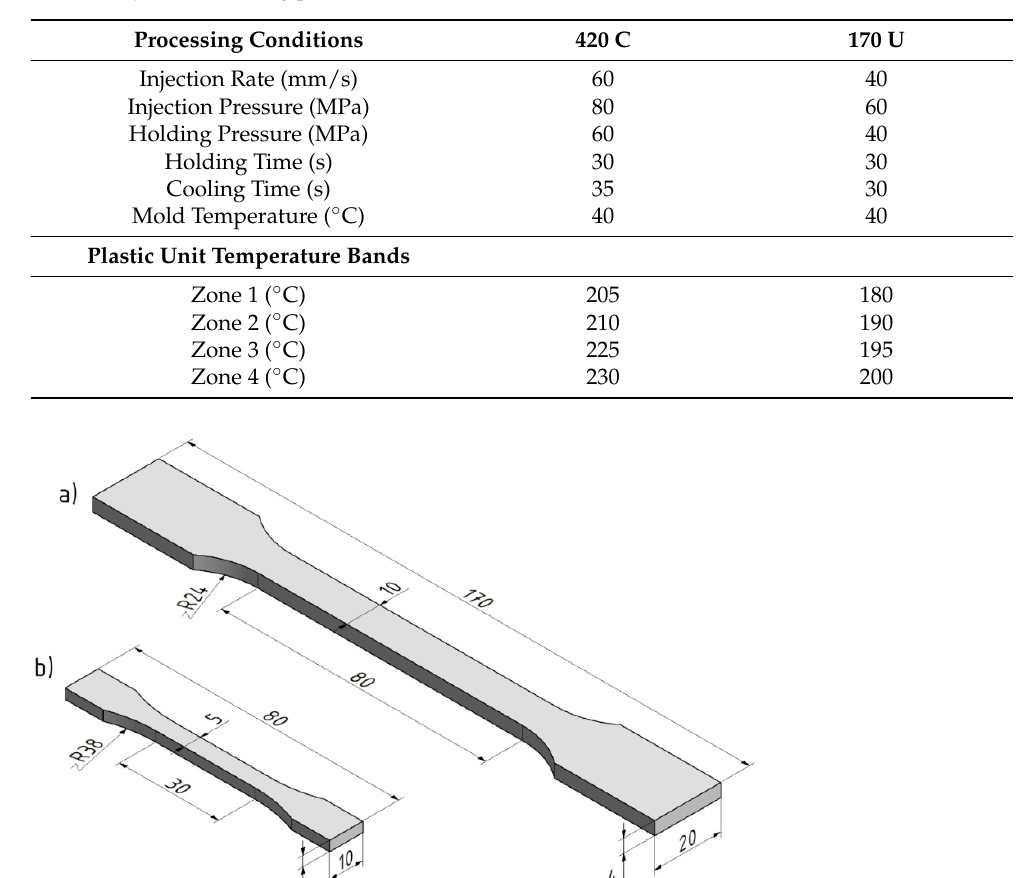
Table 1. Injection molding parameters.